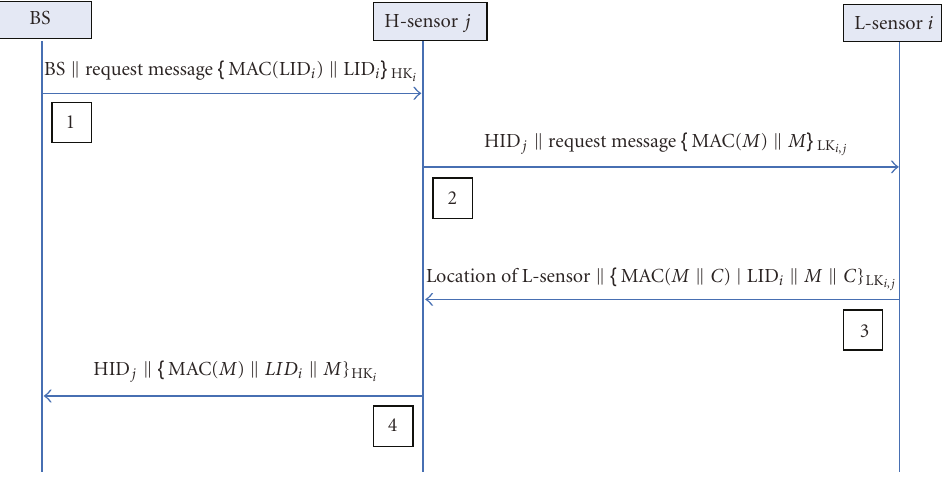
Figure 4: BS requires the data from the specific